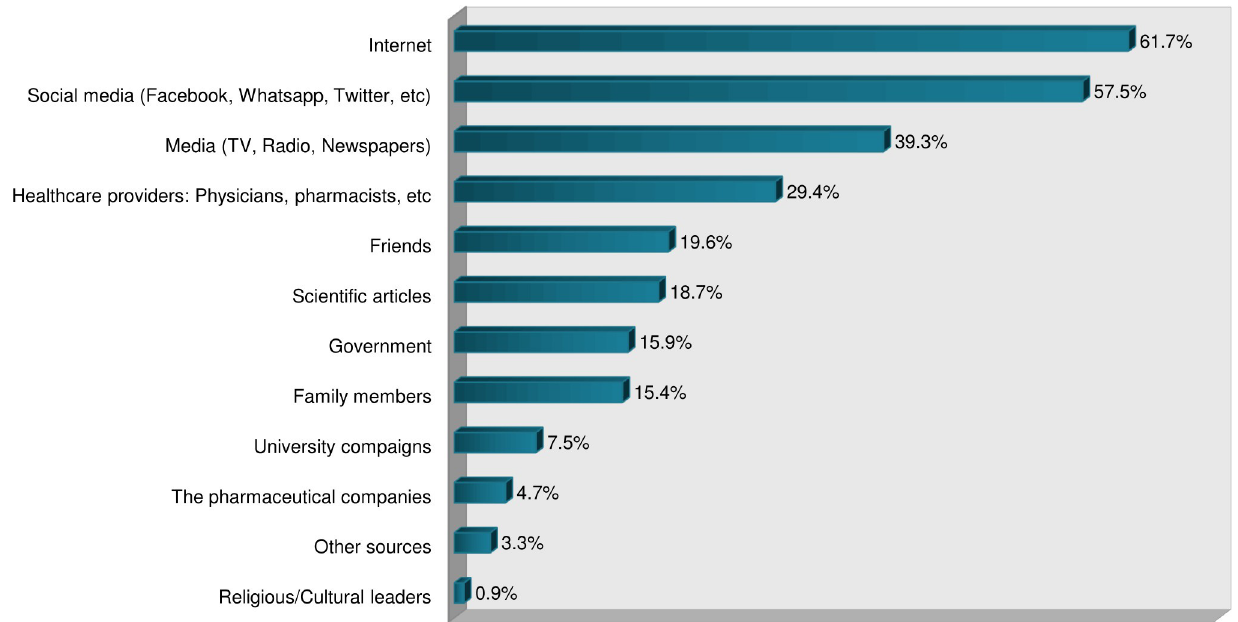
Fig 1. Sources of information regarding COVID-19 pandemic and vaccines among medical students at IUA, Khartoum, Sudan, 2021 (n = 217).